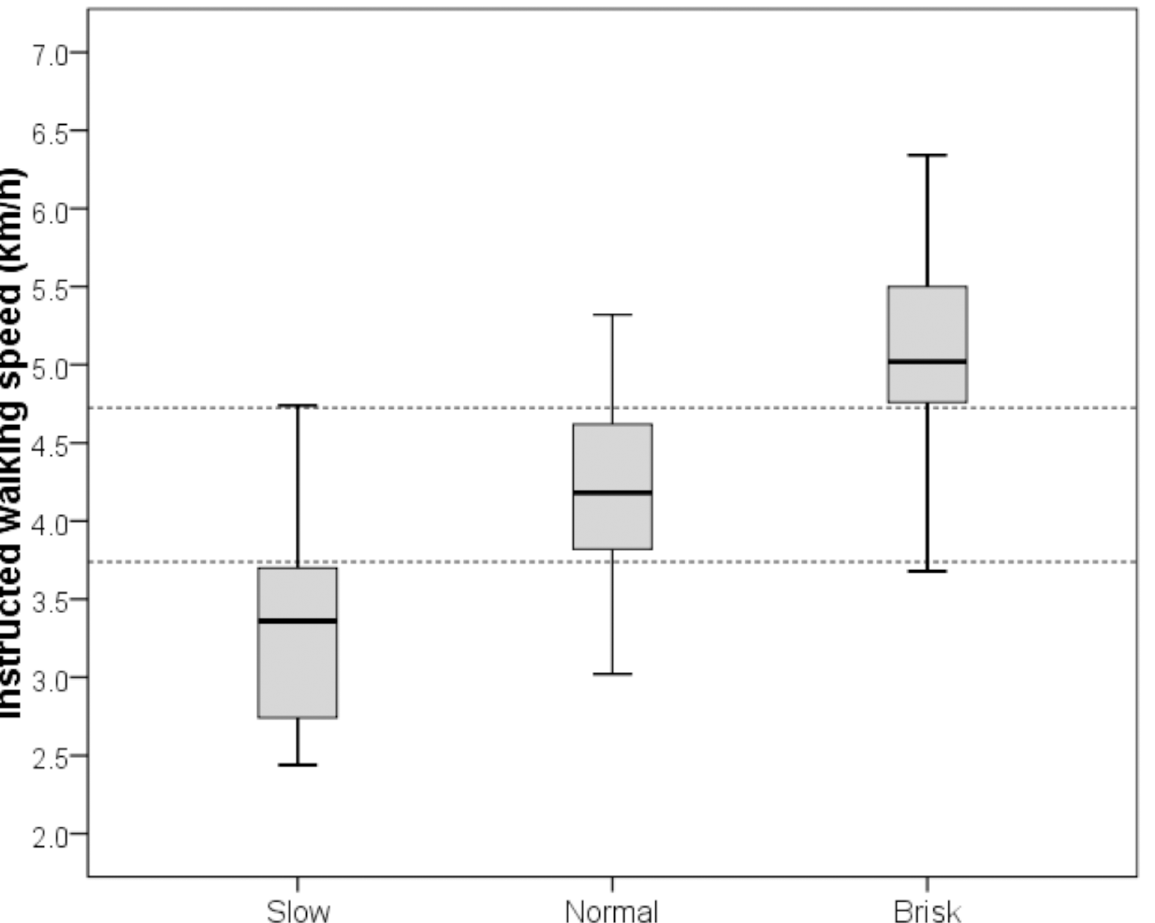
Fig 1. Percentiles of participant-defined speeds used for restructuring. The upper dotted line represents the 25th percentile of brisk walking, and the lower dotted line marks the 75th percentile of slow